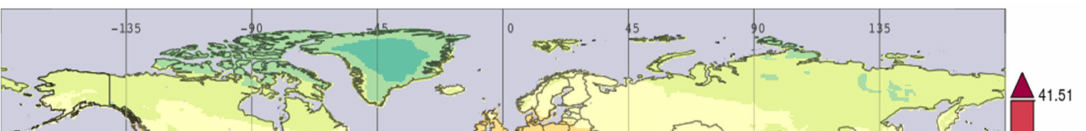
Figure 1. Time averaged map of surface absorbed longwave radiation, assuming clear sky and no aerosol monthly 0.5 × 0.625 deg over January 1990–January 2021 (W/m − 2 )